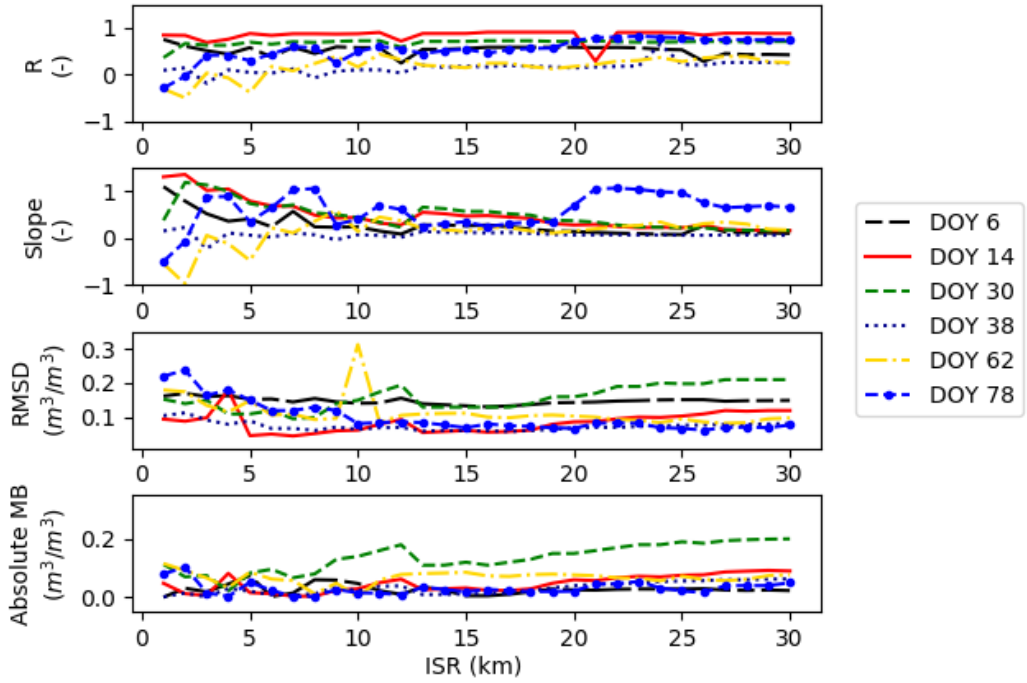
Figure 9. Correlation coefficient (R), slope of the linear regression, absolute mean bias (MB) and root mean square difference (RMSD) between 100 m resolution disaggregated and in situ SM for a range of ISR values (from 1 km to 30 km) for each sampling date